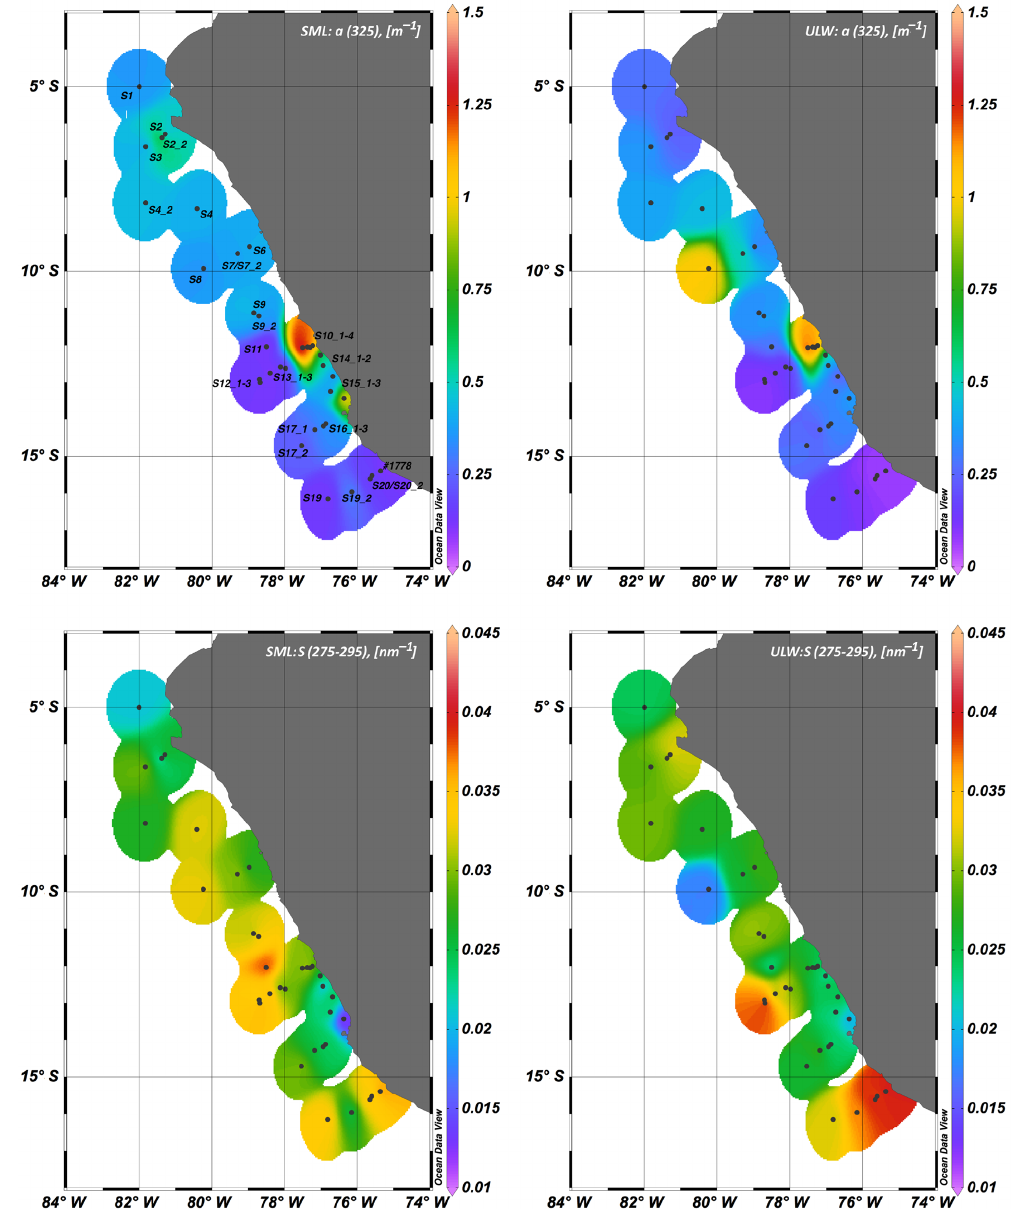
Figure 3. CDOM absorption coefficient a (325), [m − 1 ], in SML and underlying water (ULW) and spectral slope parameter between 275 and 295nm, S (275–295), [nm − 1